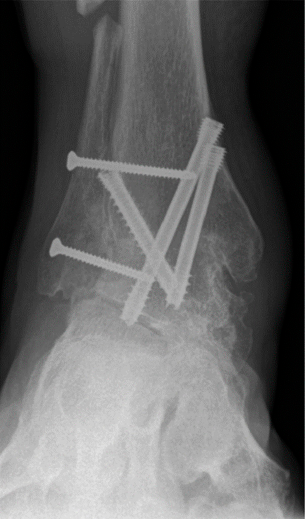
Figure 4. A 62-year-old female patient presenting complete union of the tibiotar and distal tibiofibular joints at 4 months